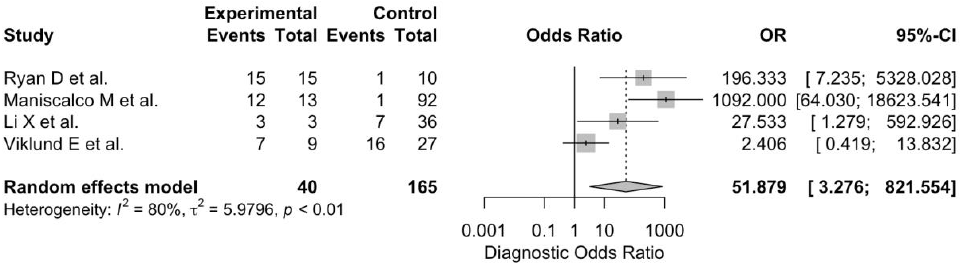
Figure 6. A forest plot representing the pooled estimate of diagnostic odds ratio (DOR) for SARS- CoV-2 Real-Time Quantitative Polymerase Chain Reaction (RT-qPCR) performed on specimens of exhaled breath condensate. Pooled DOR was 51.879 (95%CI 3.276 to 821.554), and heterogeneity was substantial (I 2 80.2%, p = 0.002).